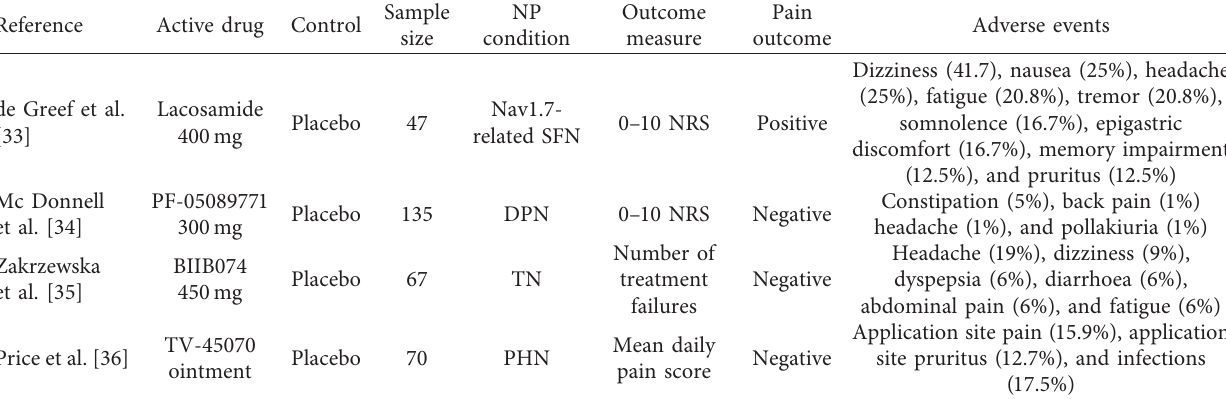
Table 6: Randomized, double-blind, controlled trials testing the effect of sodium channel blockers.